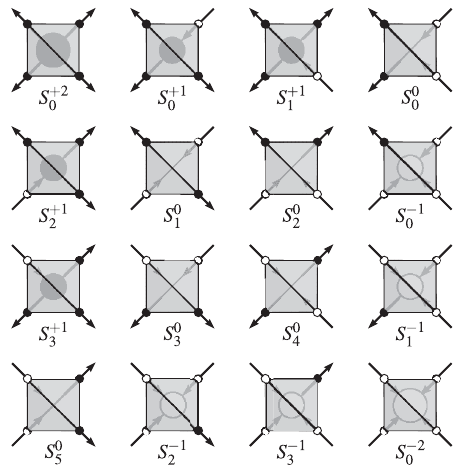
FIG. 10. The 16 states S Q μ of a single tetrahedron organized by charge Q ¼ 0 , (cid:2) 1 , (cid:2) 2 , as used in Eq.